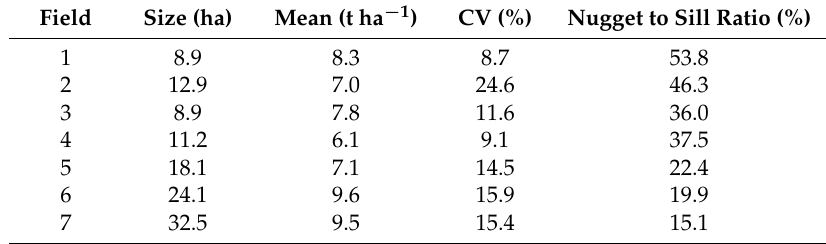
Table 3. Principal descriptive and spatial statistics of the seven yield datasets under